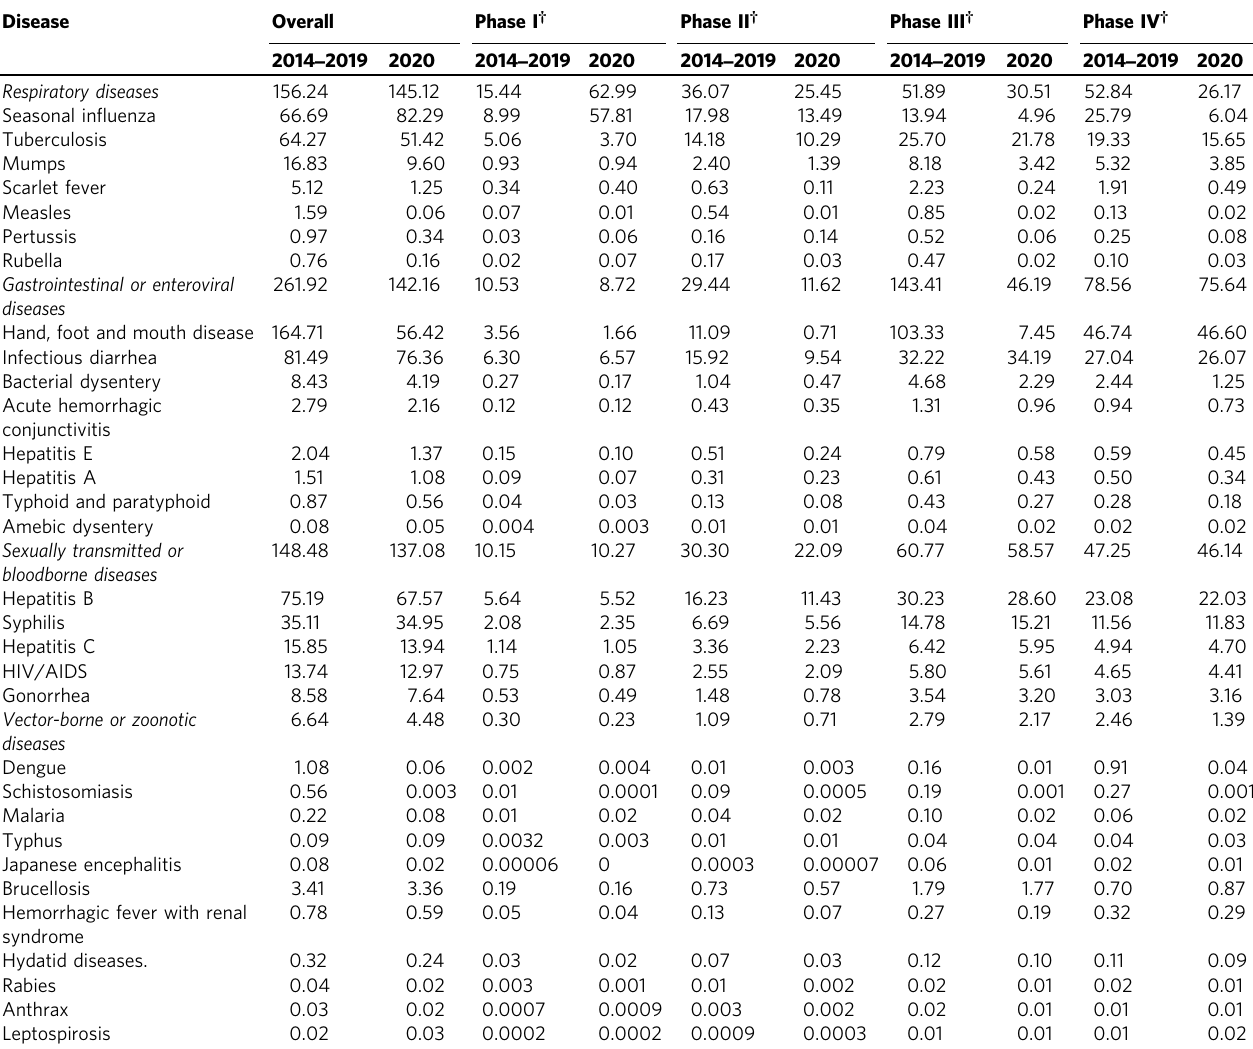
Table 1 Comparison of crude average annual incidence (/100 000) of 31 noti fi able infectious diseases between 2014 – 2019 and 2020 in the mainland of China.